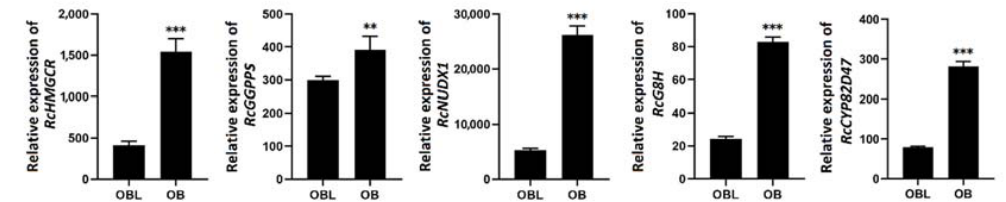
Figure 3. RT − qPCR analysis of geraniol metabolism − related genes. Data are means ± standard de ‐ Figure 3. RT–qPCR analysis of geraniol metabolism-related genes. Data are means ± standard viation of three biological replicates. ** p < 0.01, *** p < 0.001 (Student’s t − test). deviation of three biological replicates. ** p < 0.01, *** p < 0.001 (Student’s t